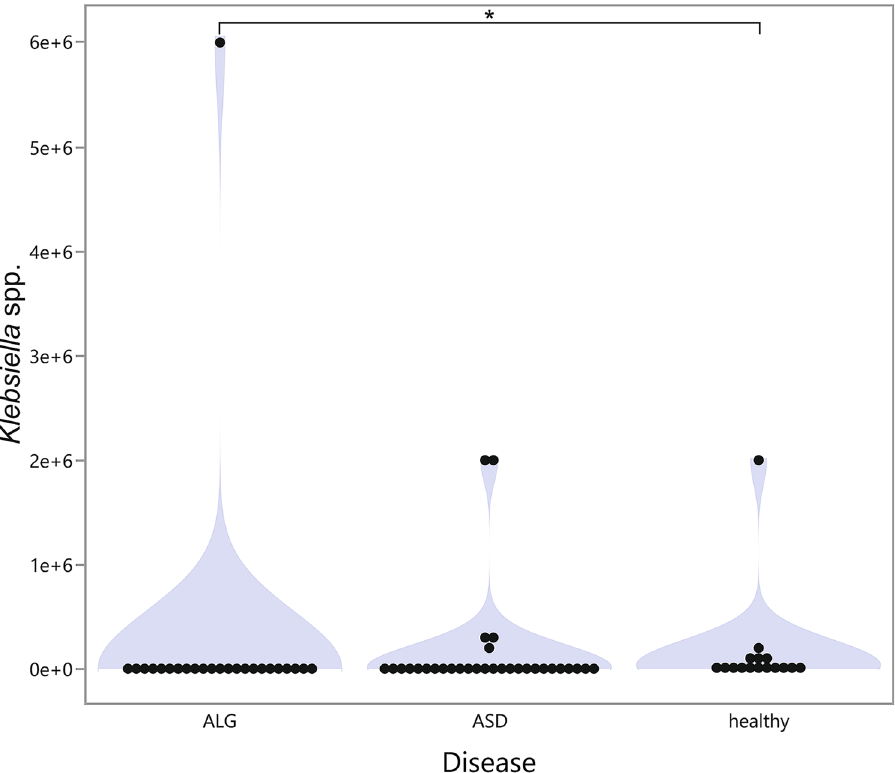
Figure 1. Violin plot of Klebsiella spp . level in the stool of children with ASD, allergies, and in the healthy group regardless of probiotic usage. * p <